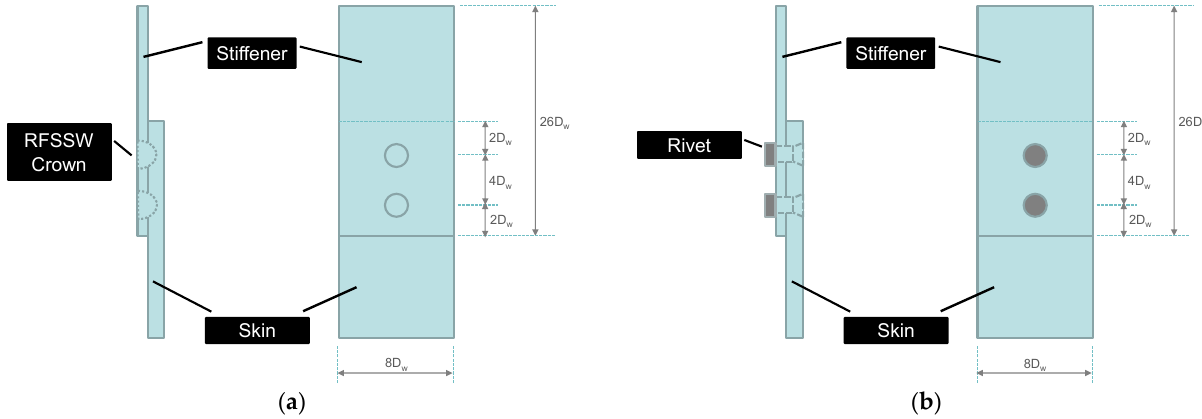
Figure 4. Two-spot coupon configurations in accordance with NASM-1312-4: ( a ) 2-refill-spot-weld coupon configuration and ( b ) 2-rivet-joint coupon configuration. D w is the refill spot weld diameter, which is 7 mm.